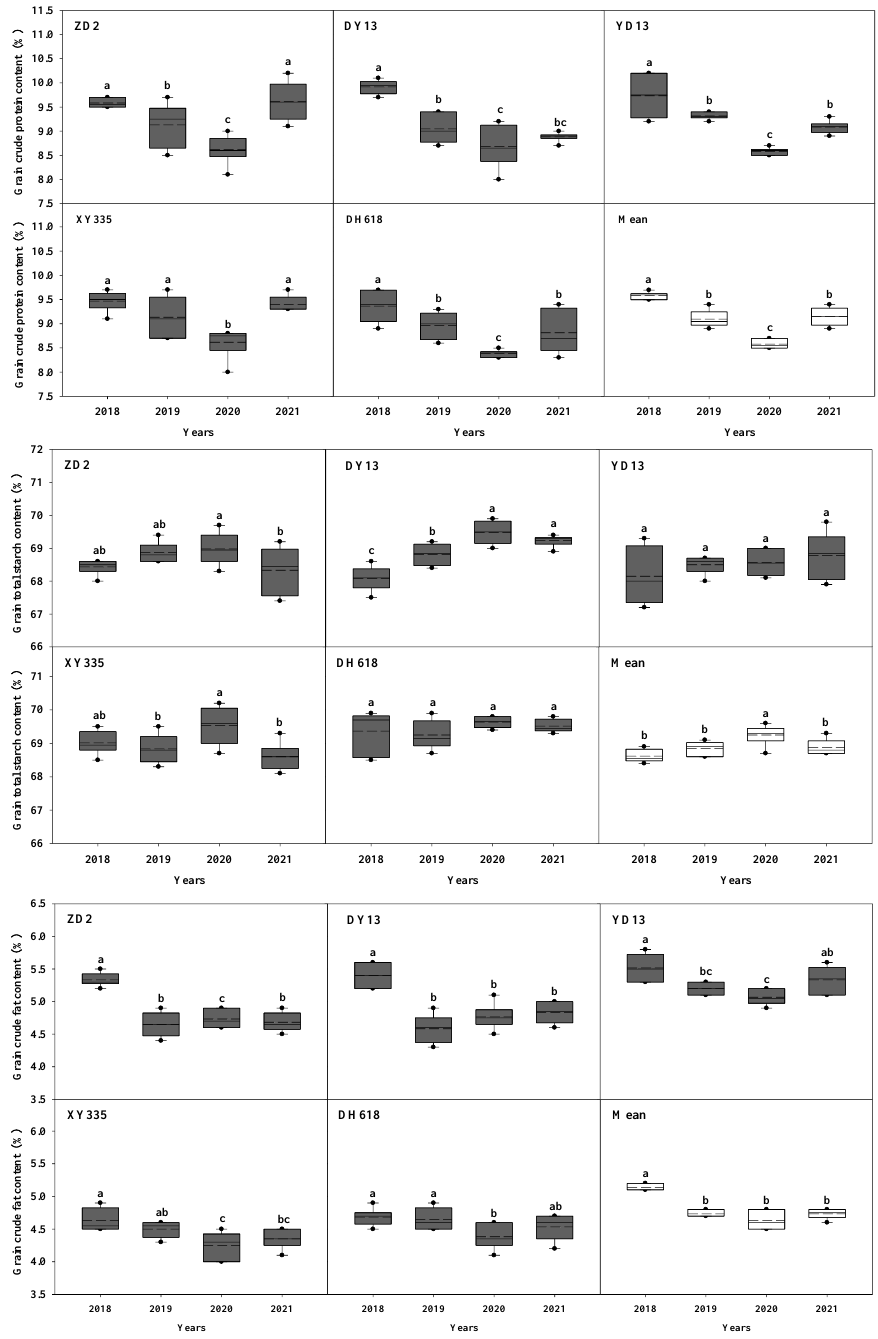
Figure 3. The difference of grain nutritional quality of maize hybrids in different years. Note: In the boxplot, the solid line represents the median, the dotted line represents the average, and the top and bottom of the box represent the upper and lower quartiles. Different letters indicate signif- icant difference ( p < 0.05). The correlation analysis between the 100-grain weight and grain nutritional quality showed (Figure 4) that the 100-grain weight was significantly negatively correlated with grain crude protein content ( −0 .4200), extremely significantly negatively associated with grain crude fat content ( −0 .8108), and exceptionally significantly positively correlated with grain total starch content (0.6268), in 2018. In 2019, there was no significant correlation between the 100-grain weight and grain crude protein content, but a significant negative correlation with grain crude fat content ( −0 .4224), and a very significant positive correla- tion with grain total starch content (0.4747). In 2020, there was no significant correlation between the 100-grain weight and grain crude protein content, but a very significant